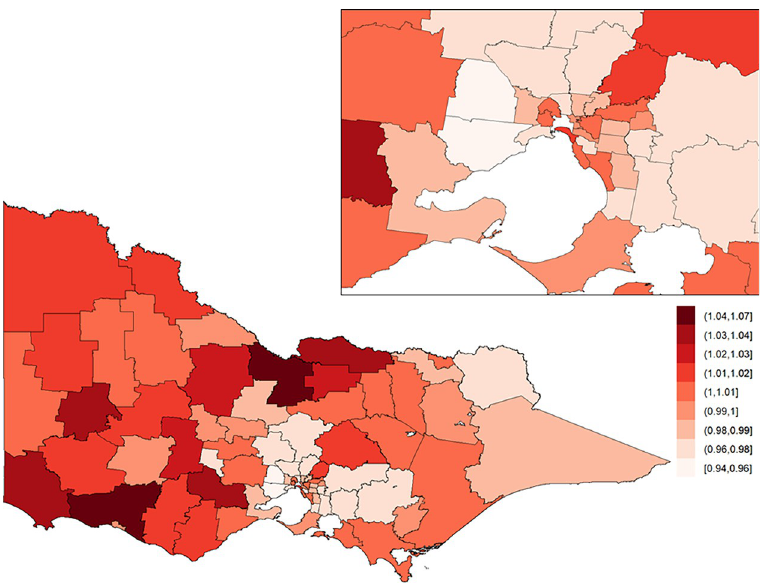
Fig 7. Posterior mean of the area-specific relative risk of injury by motor vehicle collision in Victoria. Here, a value of one indicates that the area-specific risk (averaged over time) is the same as that in the whole of Victoria, a value less than one indicates that it is lower than that in the whole of Victoria, and a value greater than one indicates that it is higher than that in the whole of Victoria. The inset on the top-right shows Greater Melbourne.